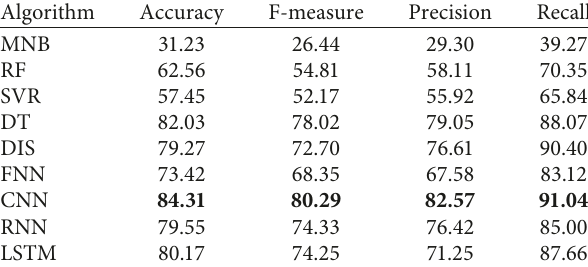
Table 6: Accuracy, F -measure, precision, and recall results of all user data based both traditional machine learning algorithms and deep learning